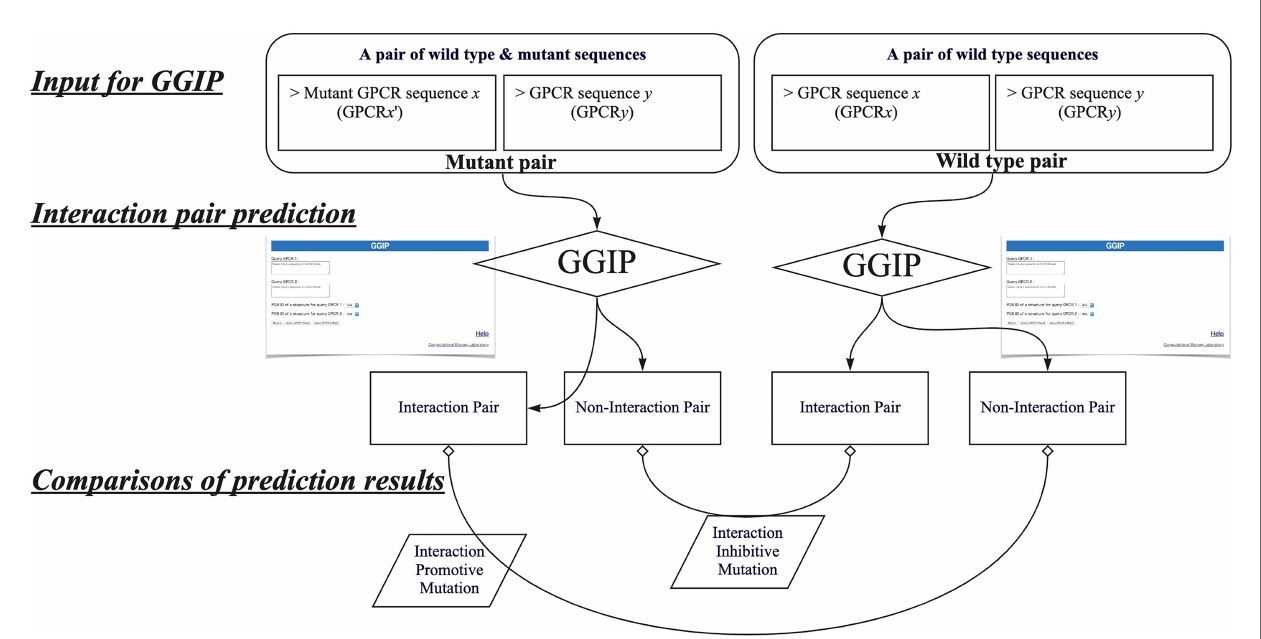
FIGURE 4 | Work fl ow to predict interaction inhibitive mutations and interaction promotive